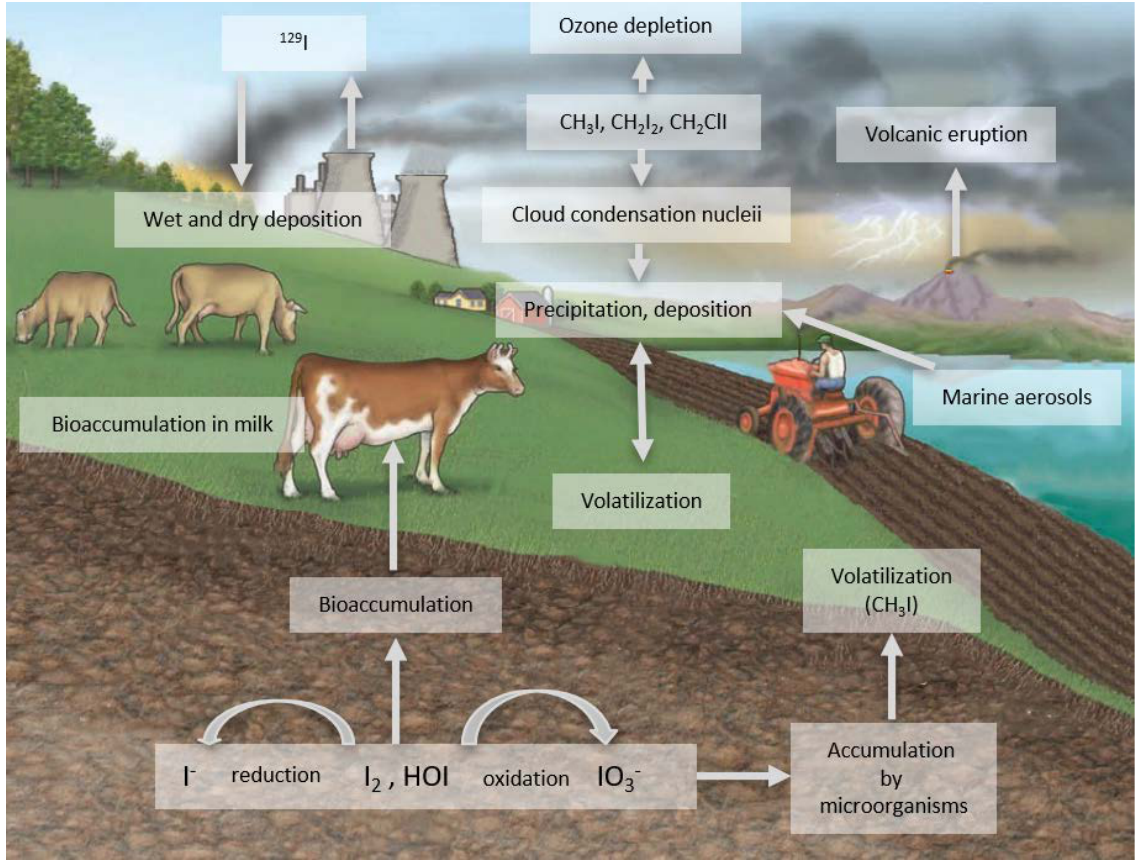
Figure 1. Biogeochemical cycle of iodine.